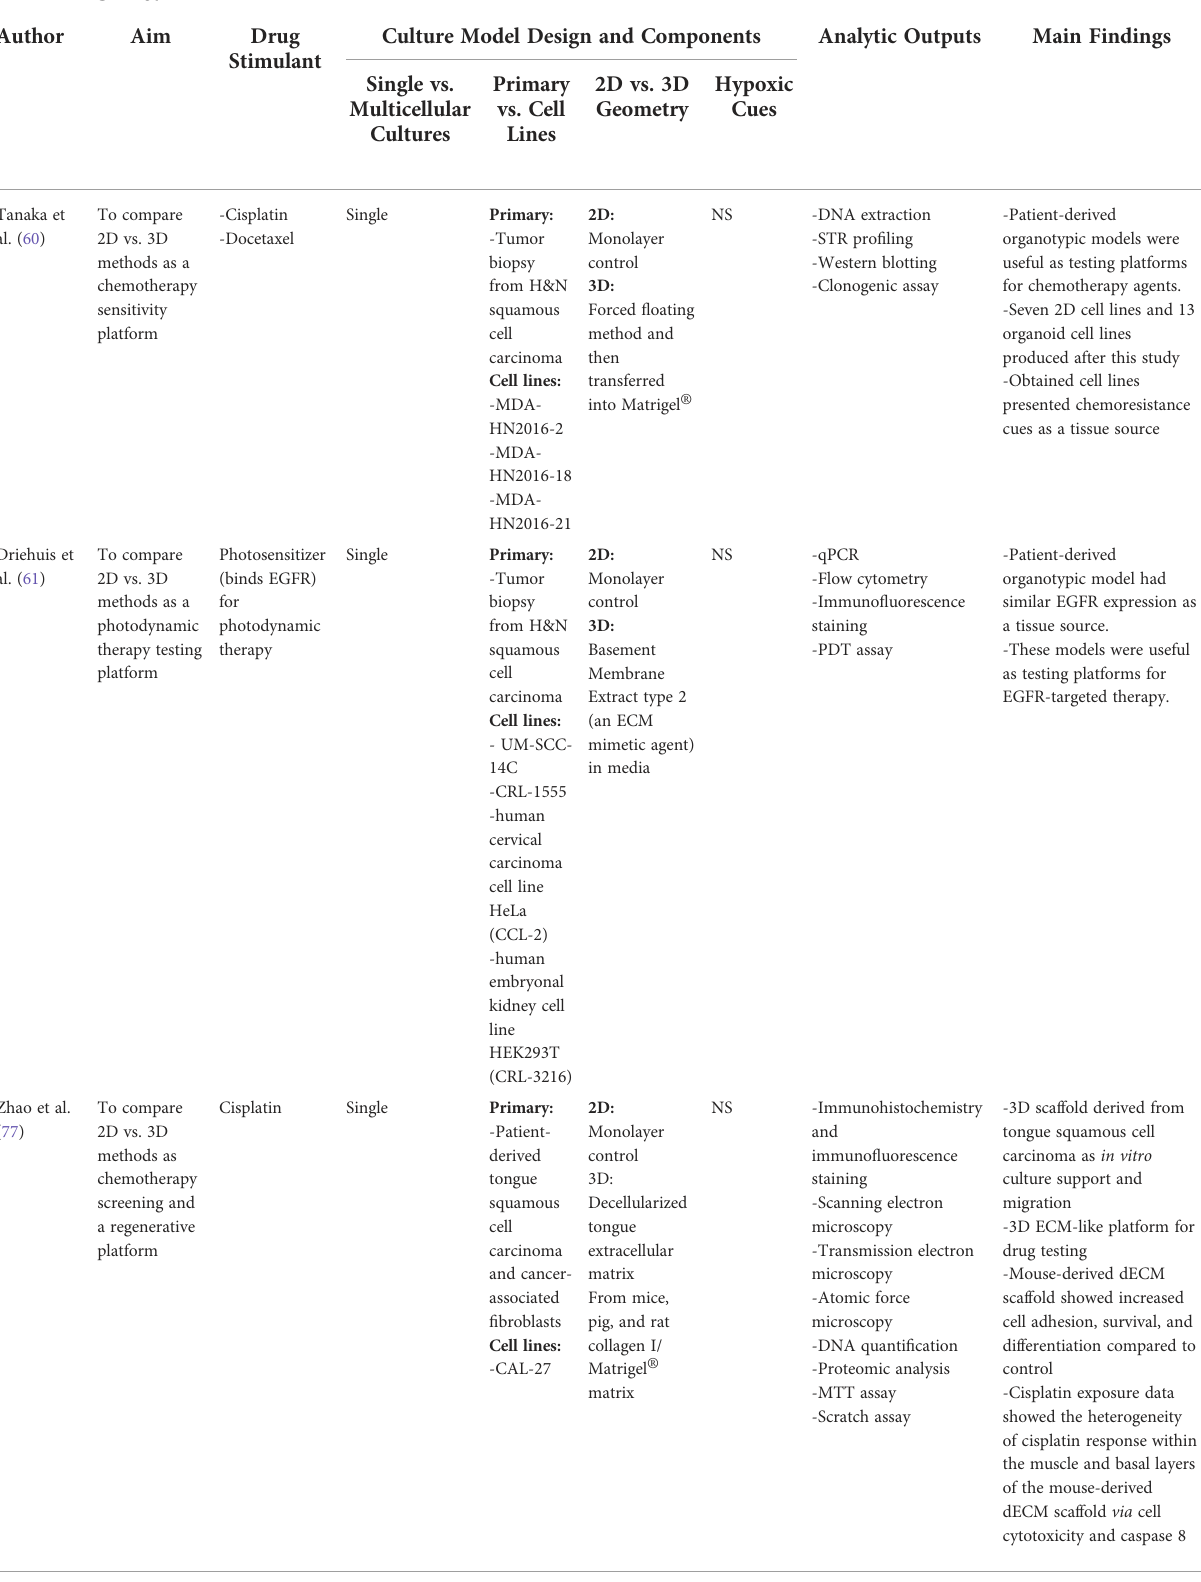
TABLE 2 Organotypic models in H&N cancer